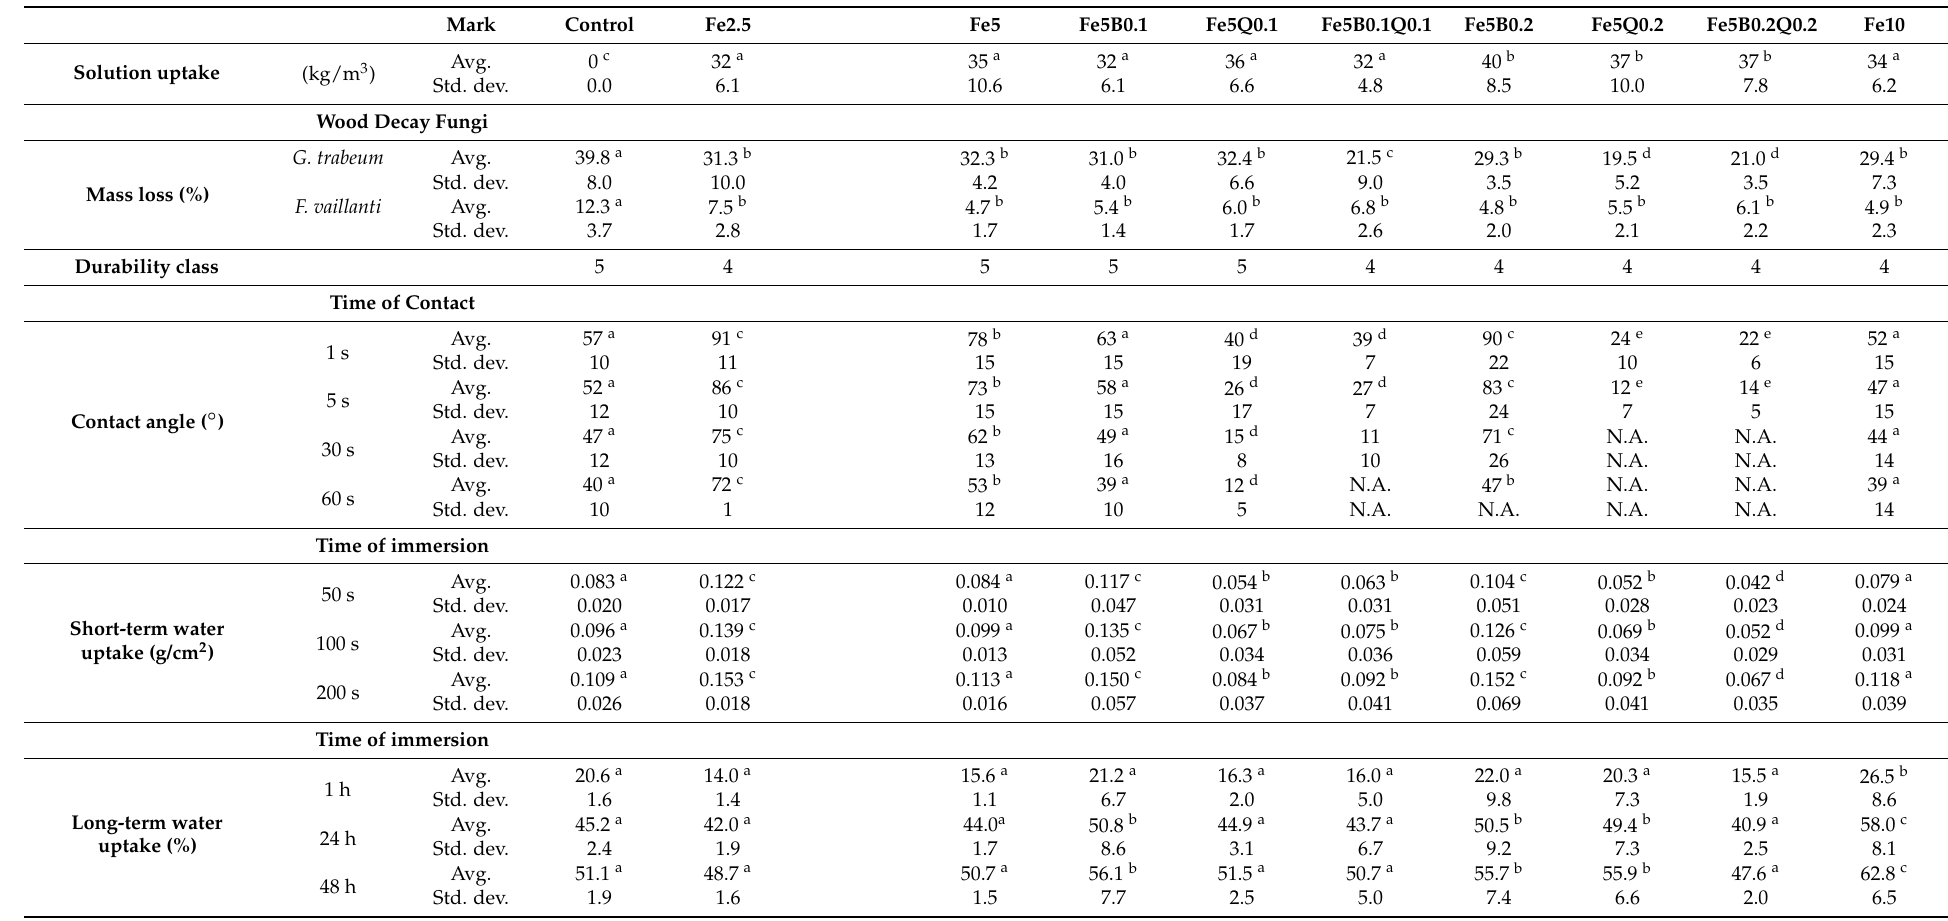
Table 2. Properties of iron(II)-sulphate-based solution for treatment of Norway spruce wood. ( p > 0.05).